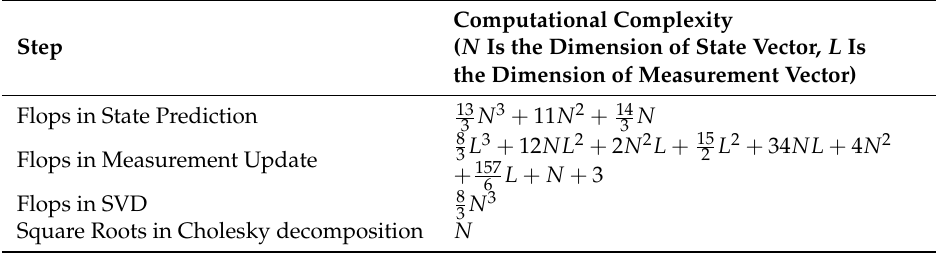
Table 4. The computational complexity of